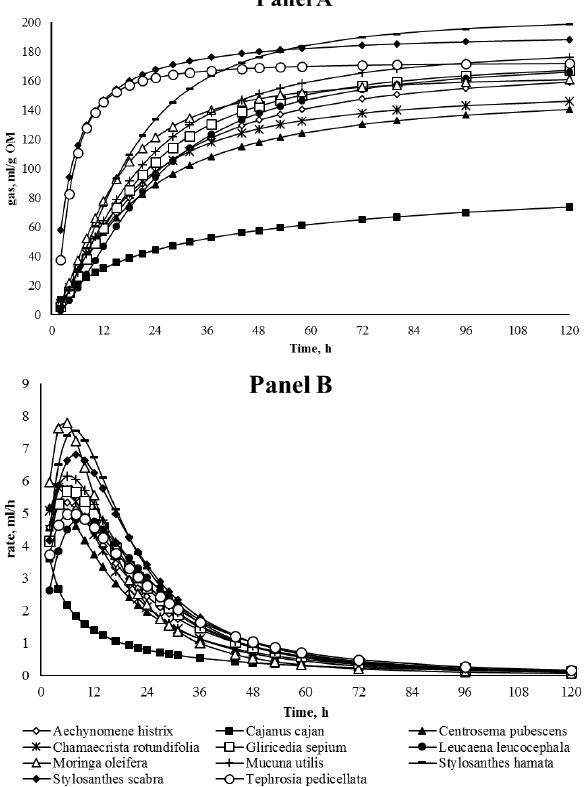
Figure 1. In vitro cumulative gas production (Panel A) and fermentation rate (Panel B) over time for grass.